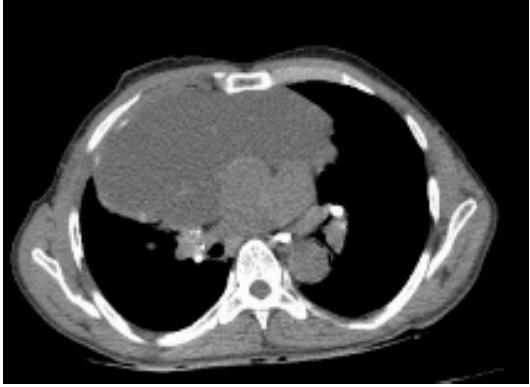
Figure 1. None contrast CT scan. A huge hypodense mass in middle and anterior mediastinum with foci of calcification.